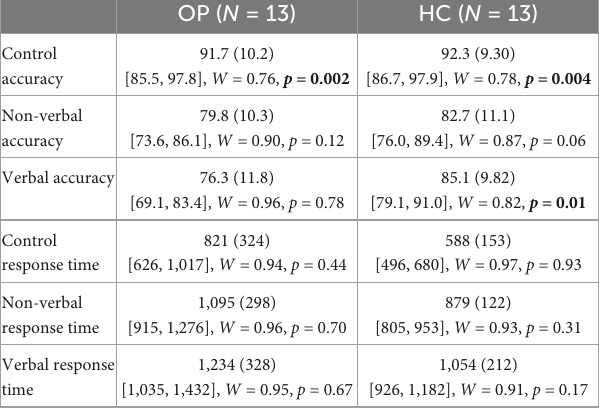
TABLE 3 Behavioral fMRI task performance by